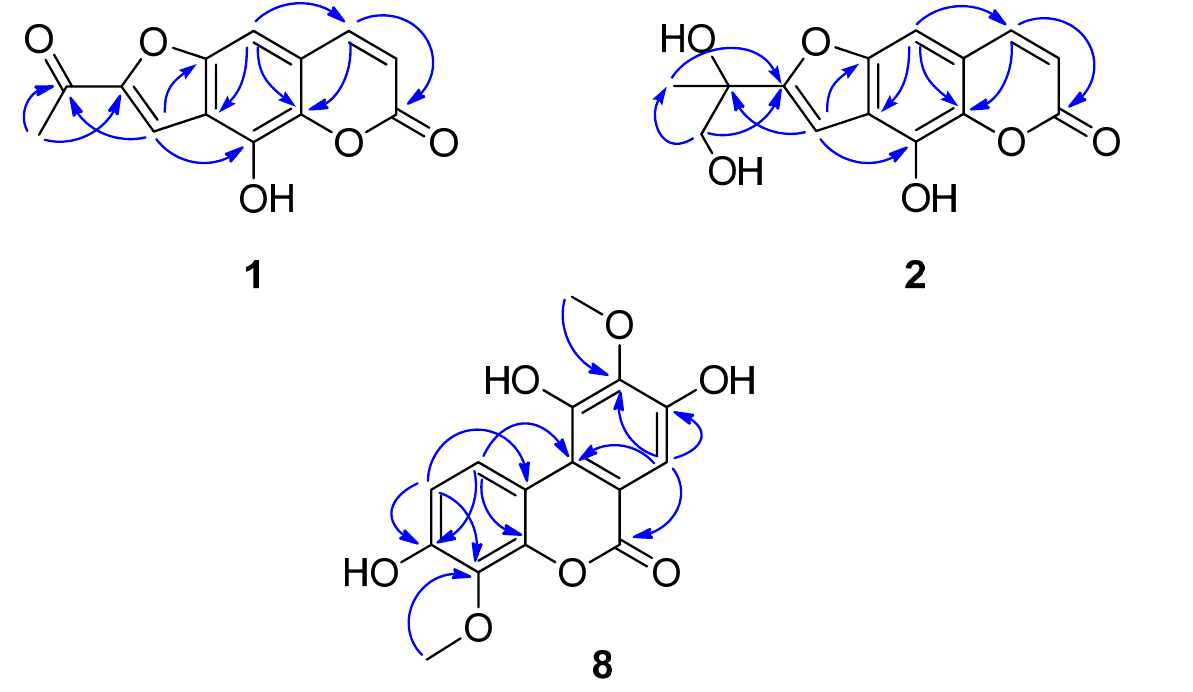
Figure 2. Key HMBC ( ) correlations of new compounds 1 , 2 and 8. Compound 2 was obtained as a purple amorphous powder. Its HR-ESI-MS (negative mode) showed a pseudo-molecular ion peak at m / z 275.0561 [M − H] − , corresponding to a molecular formula of C 14 H 12 O 6 (calcd. for C 14 H 11 O 6 − , 275.0561). The 1 H NMR spectrum of 2 (Table 1) showed signals for a tertiary methyl group at δ H 1.62 (3H, s, H-3 (cid:48) ),